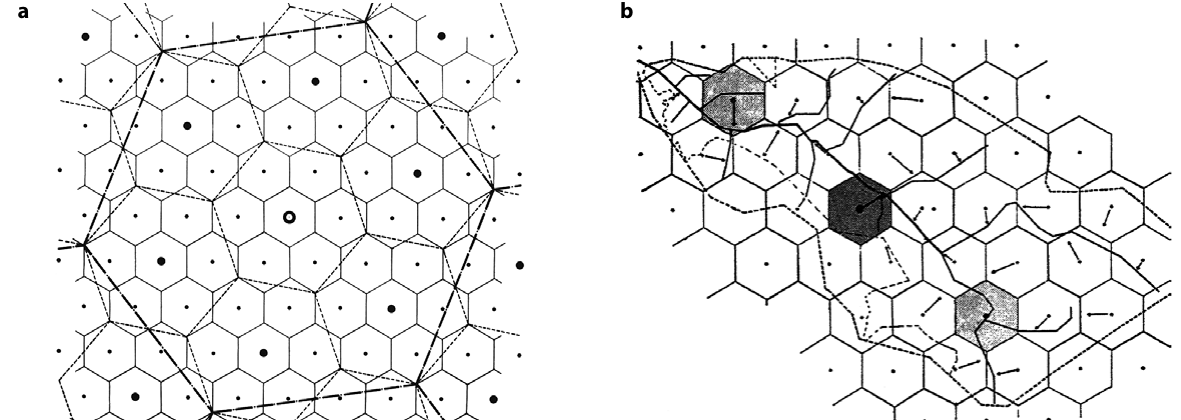
Fig. 1. Comparison of urban planning schemes: a) Model for lithuanian regional planning scheme, 1963; b) The inner structure of the regional plan for Greater Mussayib in Iraq, C. a. Doxiadis,